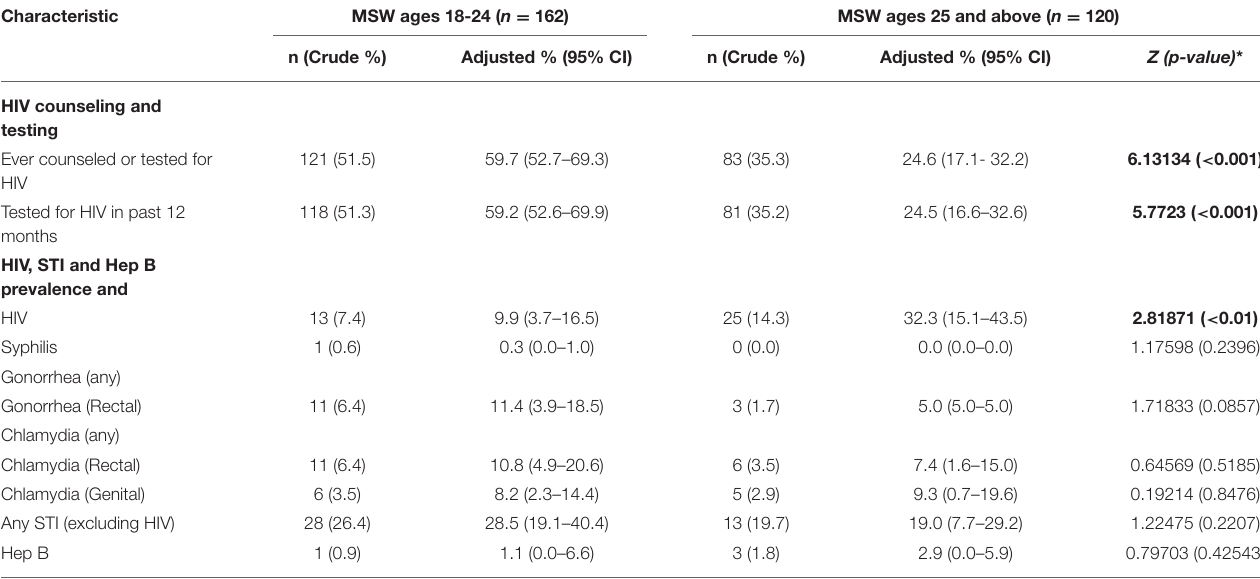
TABLE 4 | HIV, STI, and Hep B&C testing and prevalence.